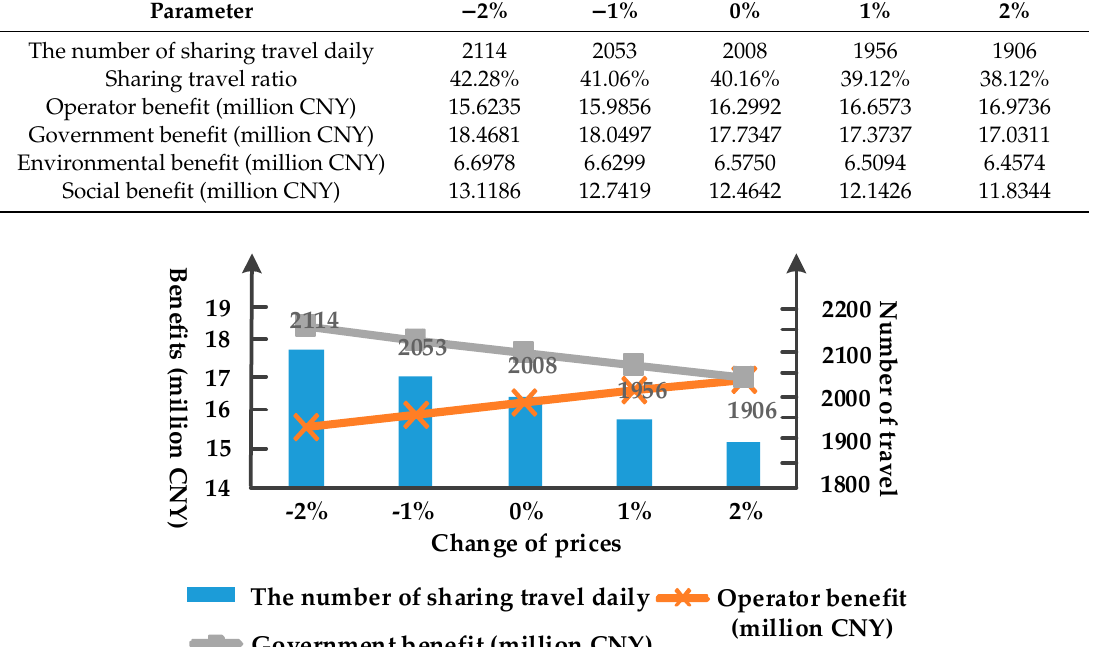
Figure 4. Changes in the benefits and number of shared travelers with pricing.